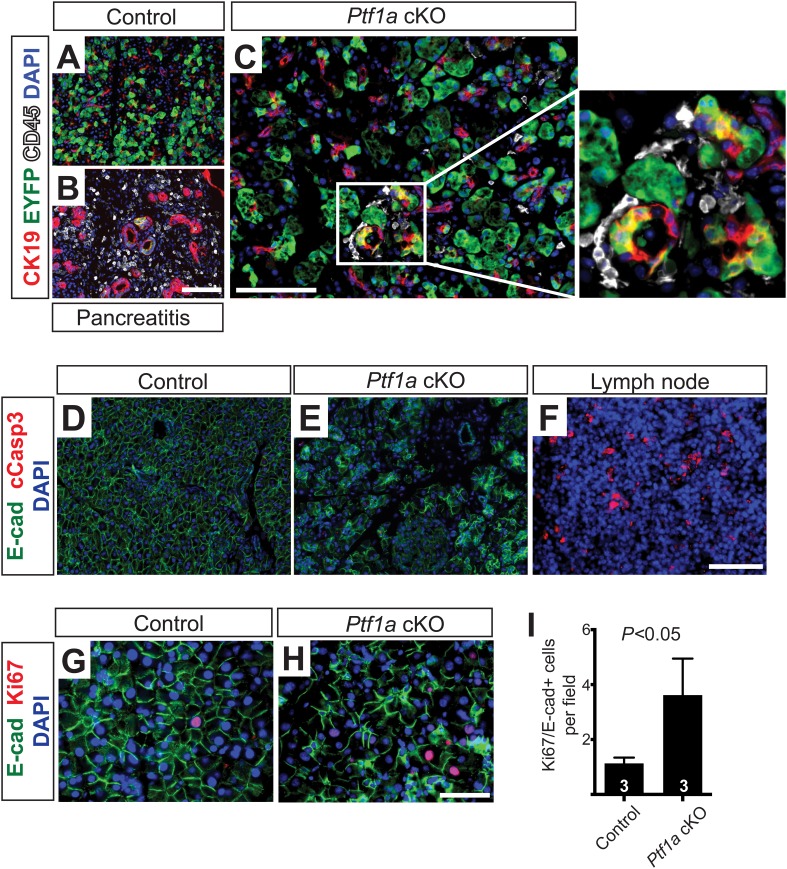
Loss of Ptf1a promotes pancreatic epithelial transdifferentiation and proliferation.(A–C) Immunofluorescence for CK19 (red), the Cre reporter Rosa26EYFP (green), and CD45 (white) in Ptf1a cKO pancreata, 2 weeks after high-dose TM administration. Caerulein-treated Ptf1a cKO pancreas included as control for pancreatitis (B). Enlarged boxed area highlights EYFP+ acinar cells expressing CK19, surrounded by CD45+ leukocytes. (D, E) Immunofluorescence for E-cadherin (green), cleaved Caspase-3 (red) and DAPI (blue) in control and Ptf1a cKO pancreata. (F) Pancreatic lymph node, positive control for cleaved Caspase-3 staining. (G, H) Immunofluorescence for E-cadherin (green), Ki67 (red) and DAPI (blue). (I) Quantification of Ki67+/E-cadherin+ cells per 40× field (n = 3 per group, p < 0.05). Scale bars: (A–F) 100 μm, (G–H) 50 μm.